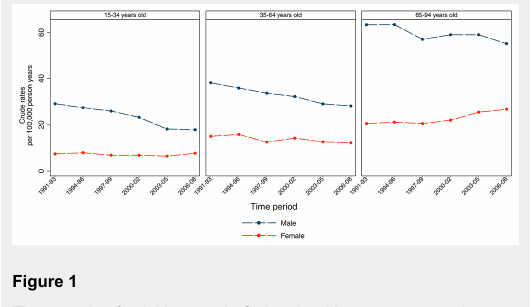
Time-trends of suicide rates in Switzerland by age group and sex, 1991–2008. In men there was a decline in all age groups (all p <0.001); in women there was no change over time in the youngest age group (p = 0.40); a slight decline in the age group 35–64 years and an increase in the oldest age group (both p <0.001).